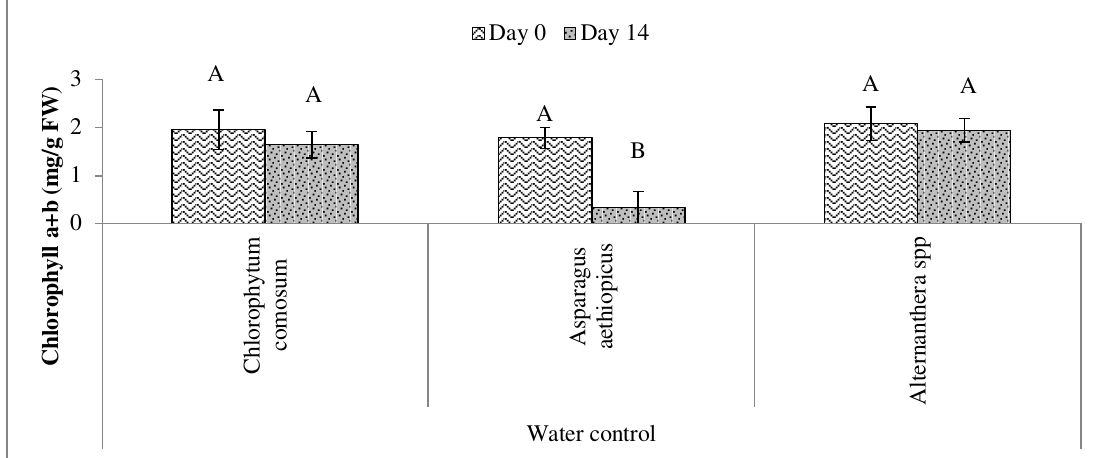
Fig. 2. Chlorophyll content (a+b) in control systems. Error bars refer to standard deviation (n = 2).